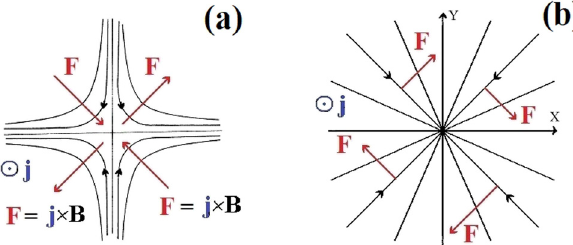
Figure 3: j B × forces for X - type con fi guration ( a ) and diverging magnetic fi eld ( b )